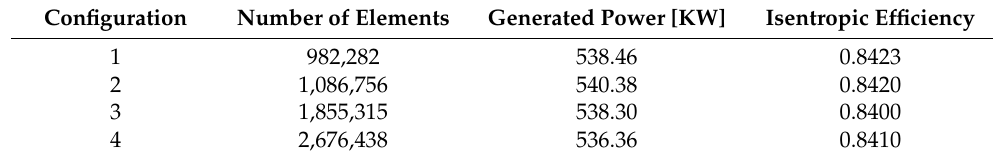
Table 2. Numerical grid analysis results.